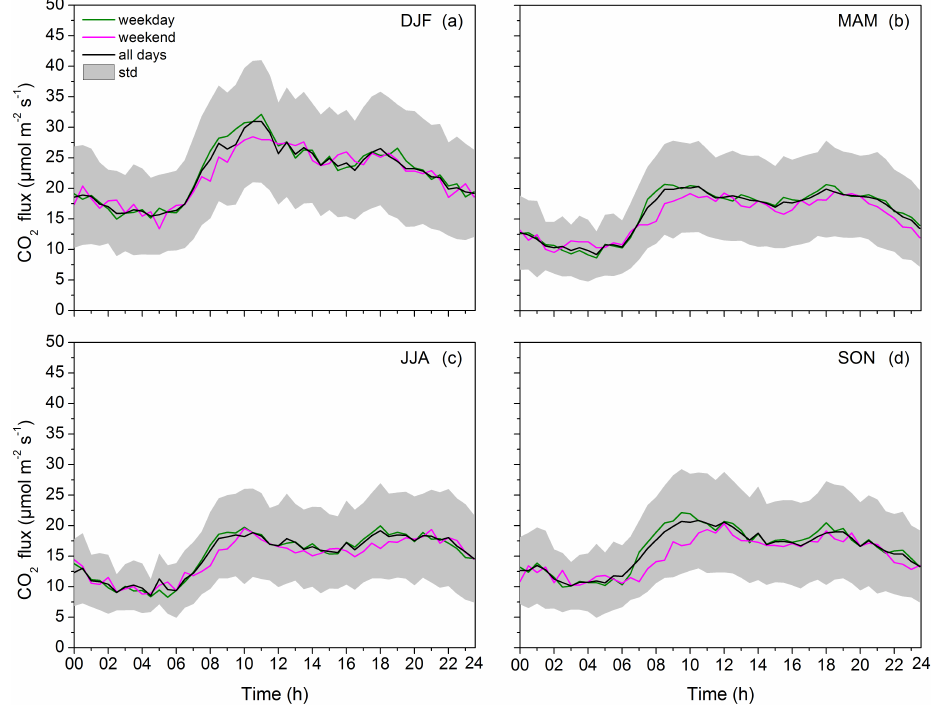
Fig. 7. Average diurnal pattern of F c for all days, weekdays and weekends separately in DJF (a) , MAM (b) , JJA (c) and SON (d) during the study period. The light gray shaded area represents one standard deviation from the mean for all